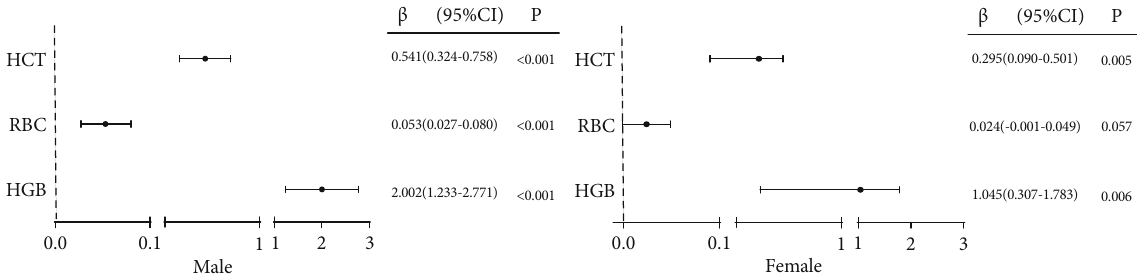
Figure 2: Forest plot of the multiple linear regression analysis of ASMI and HCT, RBC, and HGB. Abbreviations: ASMI: appendicular skeletal muscle mass index; HCT: hematocrit; RBC: red blood cell count; HGB: hemoglobin concentration. Note: multiple linear regression model adjusted for age, duration of diabetes, diabetic complications, BMI, blood pressure, HbA1c, TC, TG, ALB, SCr, smoking status, usage of hypoglycemic agents, and antihypertensive agents.